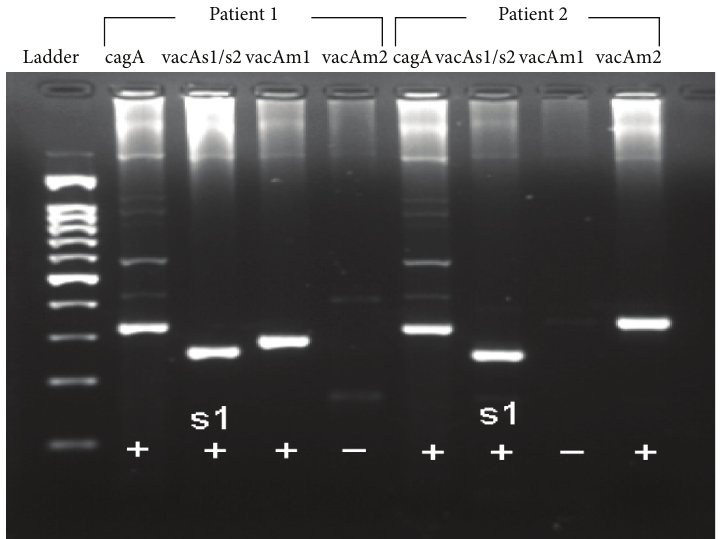
Figure 2: Results of PCR study showed the amplification products of Helicobacter- specific virulence factors cagA (324 bp), vacA s1 (259 bp), vacA s2 (286bp), vacA m1 (290 bp), and vacA m2 (352bp) such as patient 1 with CSU and positive genotypes cagA and vacA s1m1 and patient 2 (control group) with positive expression of cagA and vacA s1m2 but without CSU.